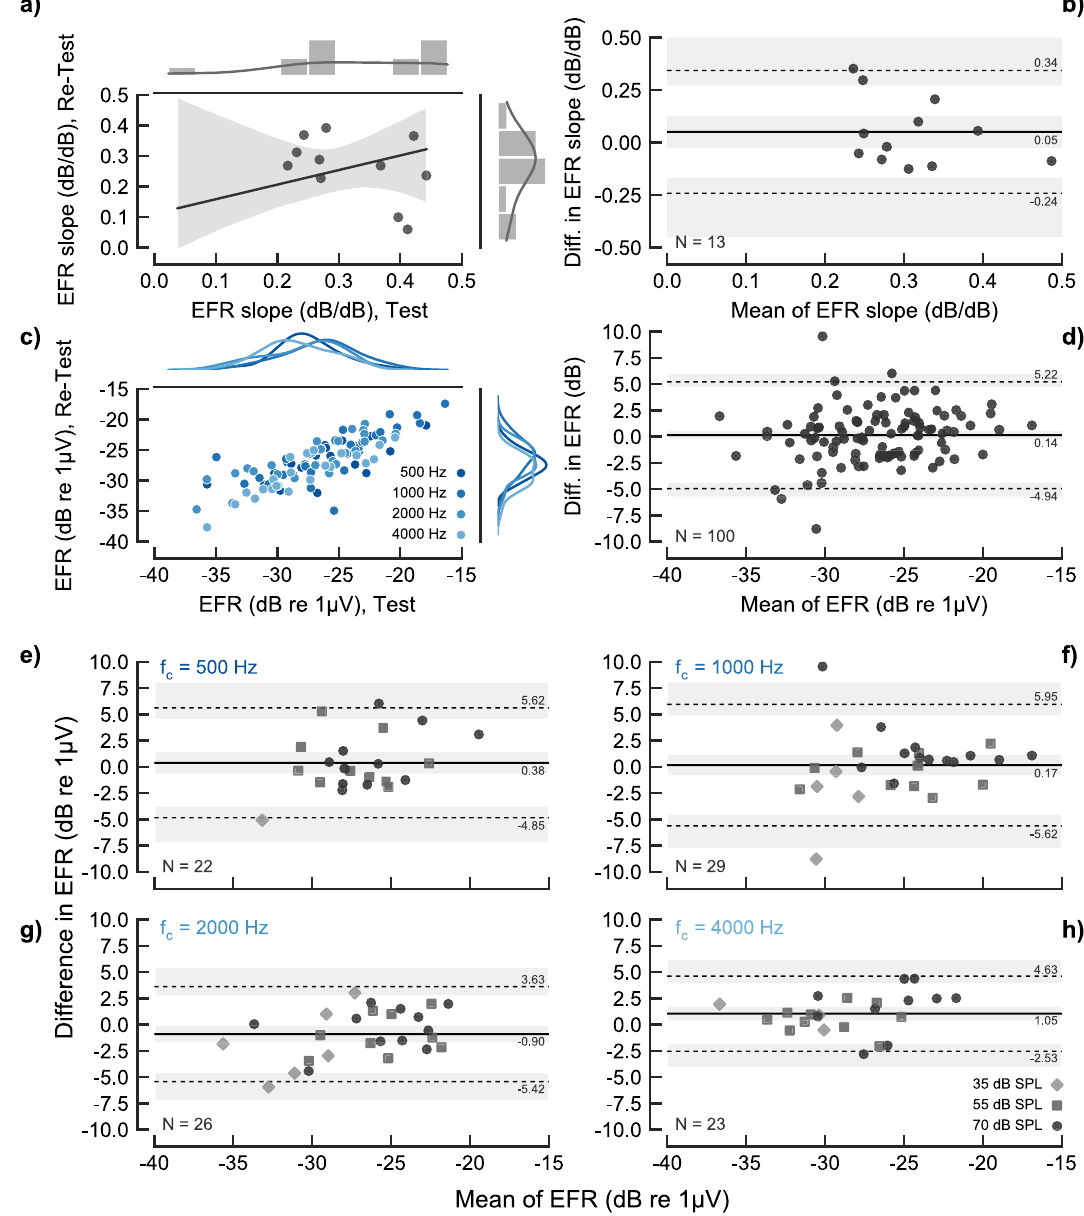
Figure 4. Test–retest repeatability analysis of the EFR magnitudes and the EFR slopes in the NH listeners. Panel a) show the relation between the test and retest data of the EFR slope. Top and right margins show a histogram and kernel density function of the data. The black-solid line and grey area in the main plot show the fit of a linear regression model and its 95% CI. Panel ( b ) shows the difference of the test–retest EFR slopes as a function of the test–retest mean (a Bland–Altman plot). The solid-black horizontal line show the mean of the differences. The dashed-grey horizontal lines show the upper and lower LoA. The corresponding values are indicated in the right side of each line, while the grey semitransparent bands show the 95% CI for each line. Panel ( c ) show the relation between the test and retest EFR magnitudes pooled across carrier frequency and level. EFR values for each carrier frequency are indicated as different intensities of blue colour. Top and right margins show kernel density functions of the distribution of the data. Panel ( d ) shows a Bland–Altman plot of the EFR test–retest data pooled across frequencies and levels. Panel ( e – h ) show Bland–Altman plots of the EFR test–retest data for the carrier frequencies of 500 Hz , 1 kHz , 2kHz and 4 kHz , respectively. Different markers indicate the stimulation level of each EFR data point, as shown in the legend in panel h). Only statistically significant EFRs were considered in the repeatability analysis, indicated by the N value in the bottom-left part of each Bland– Altman